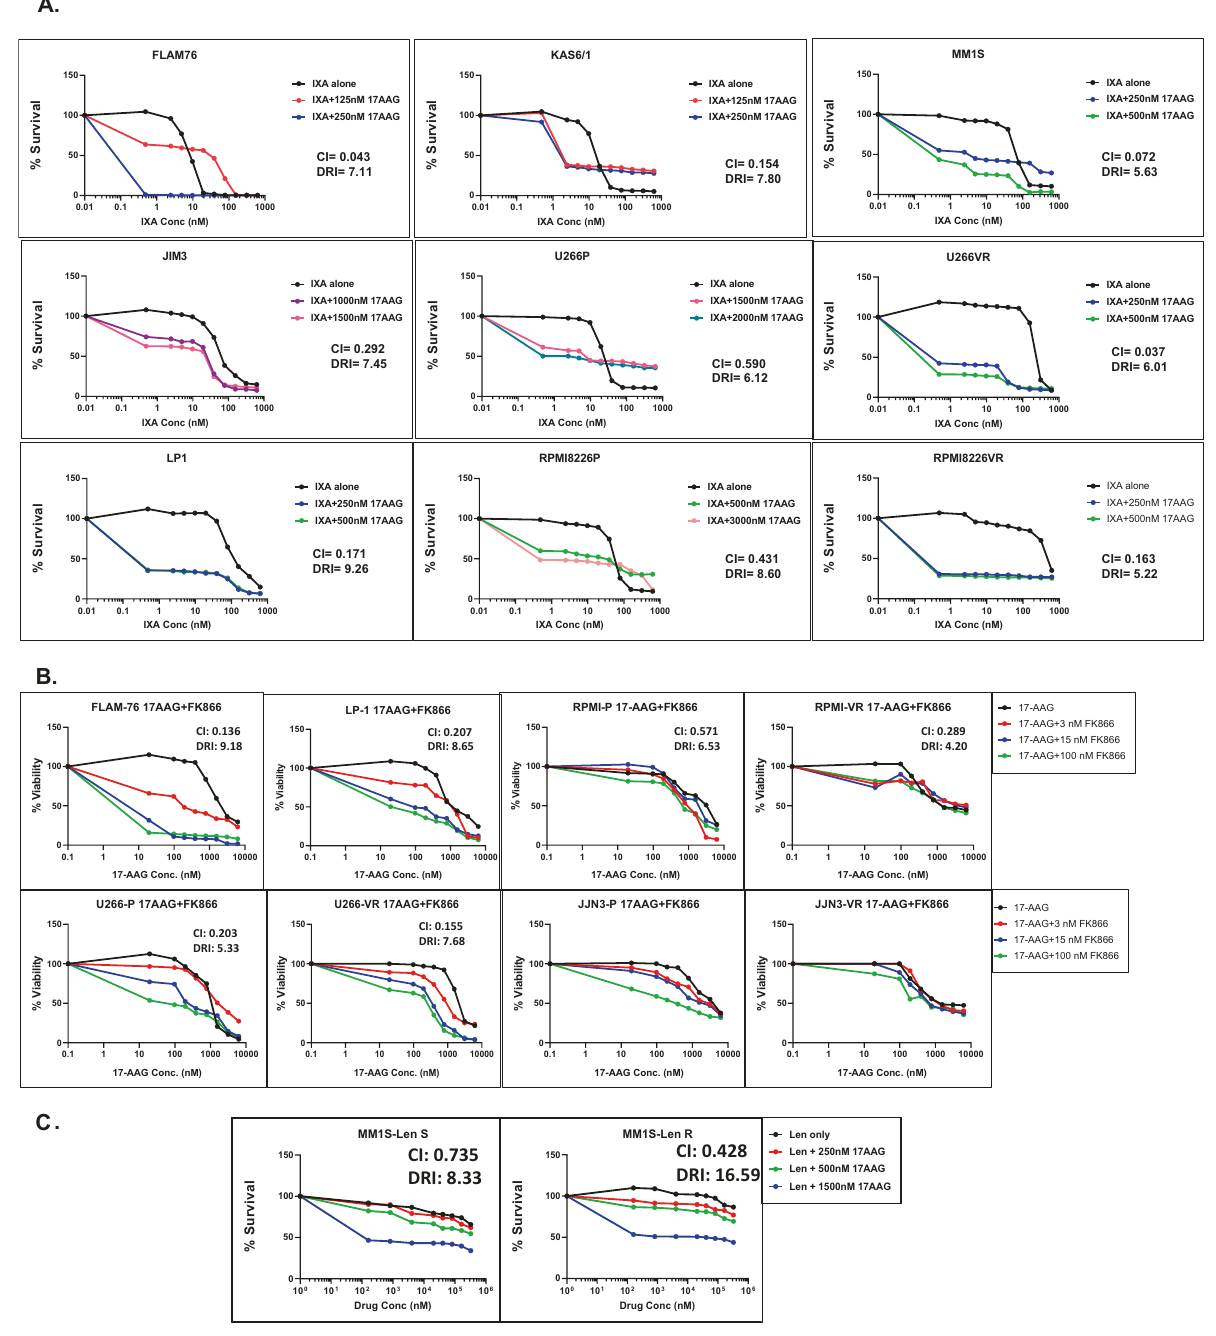
Fig. 3 The secDrug 17AAG (Hsp90 inhibitor) synergizes with A. PIs (17AAG + IXA), B. FK866 (17AAG + FK866), and C. IMiDs (17AAG + Lenalidomide). In vitro dose – response plots for secDrug combination treatment in HMCLs representing innate sensitivity, innate